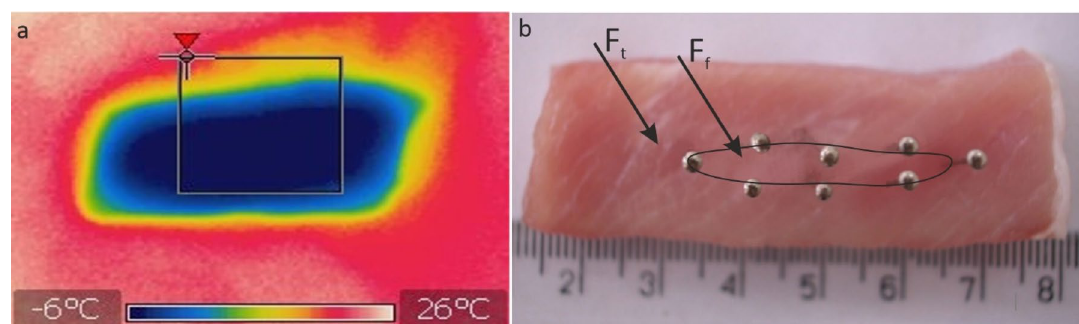
Figure 5. Section through a defrosted sample: ( a ) image of the temperature field from the thermal imaging camera (Type 559384, FLIR Systems. Inc., Wilsonville), ( b ) boundary of the frozen area—identified by puncturing with pins: F f —frozen surface, F t —thawed